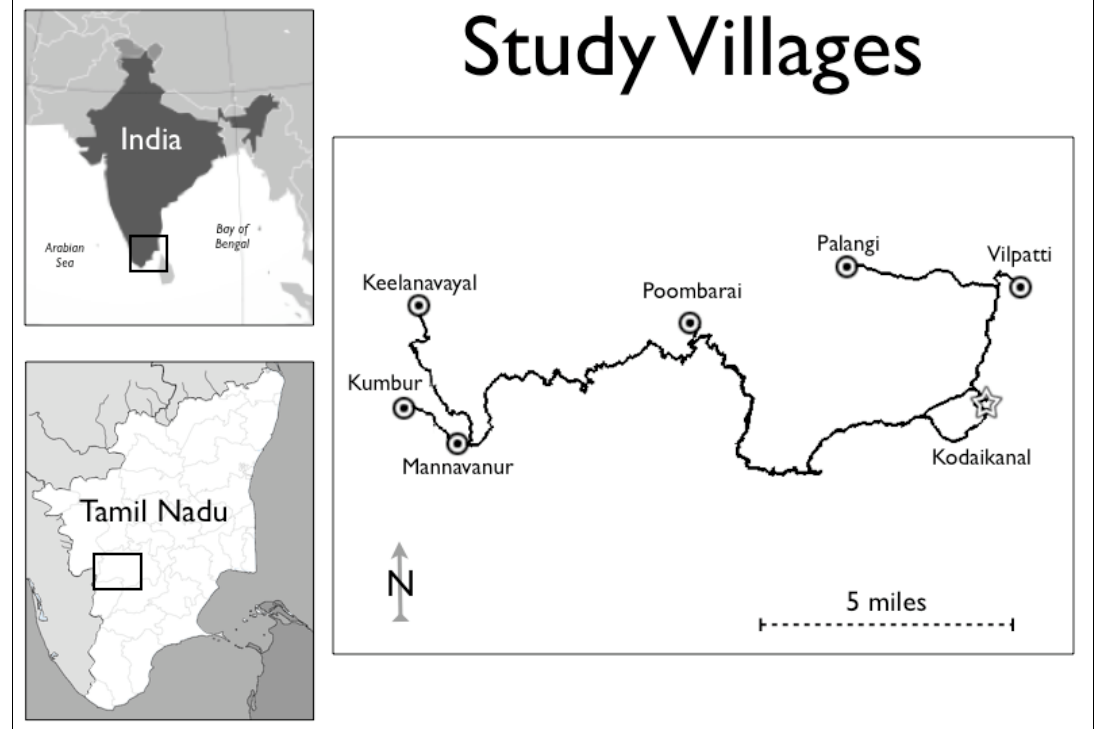
Figure A 1. Study villages in the Palani Hills, Tamil Nadu,